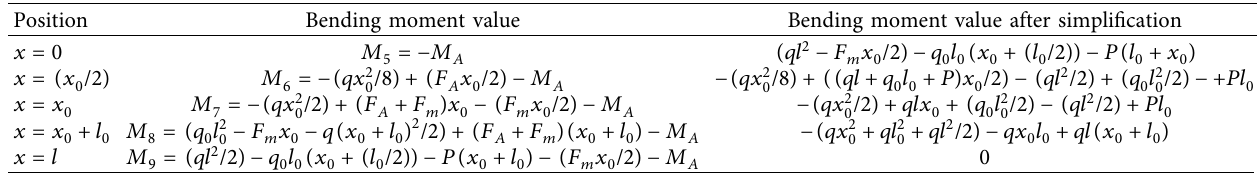
Table 1: Bending moment values at each turning